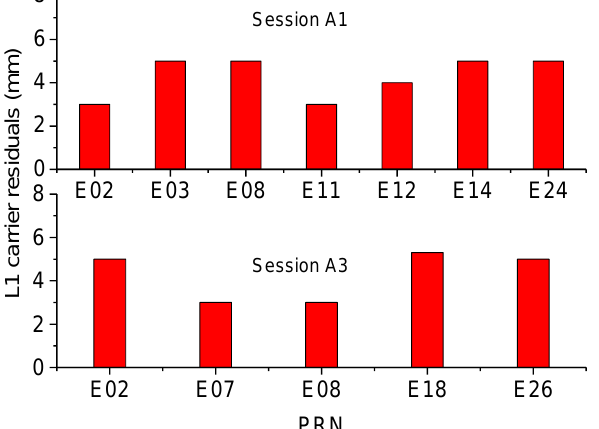
Figure 13. L1 carrier residuals of Galileo ARTK using broadcast ephemeris in Session A1 and A3 for Bs.2.